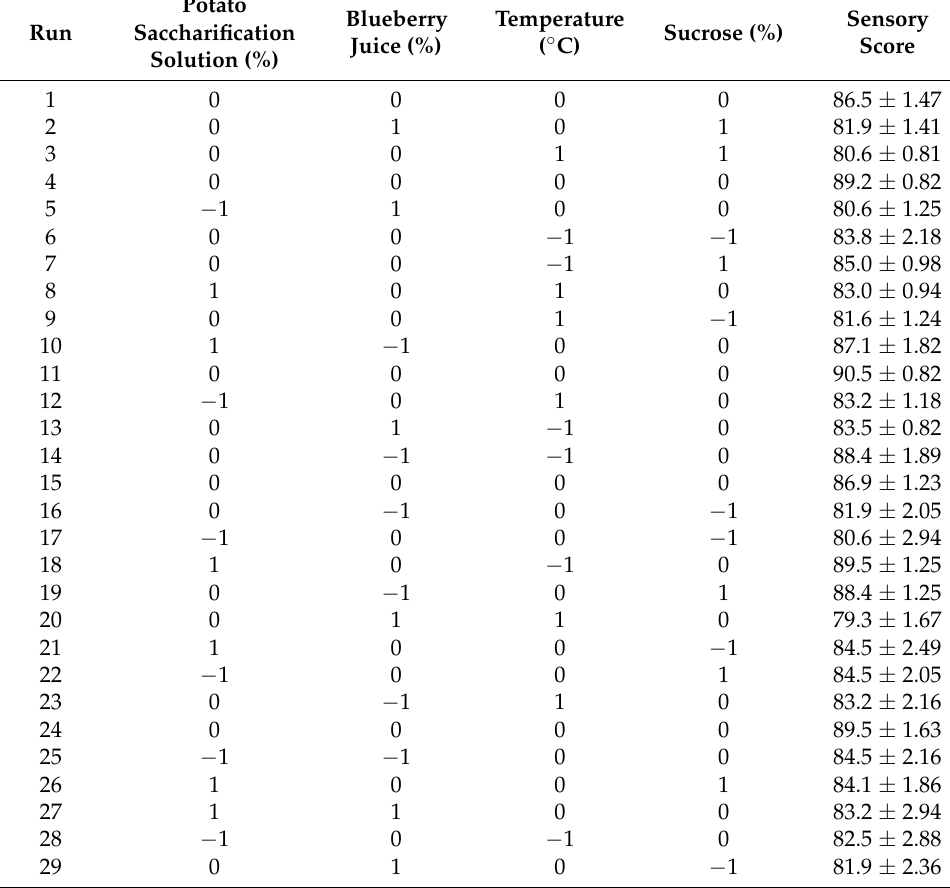
Table 5. Response surface experimental design